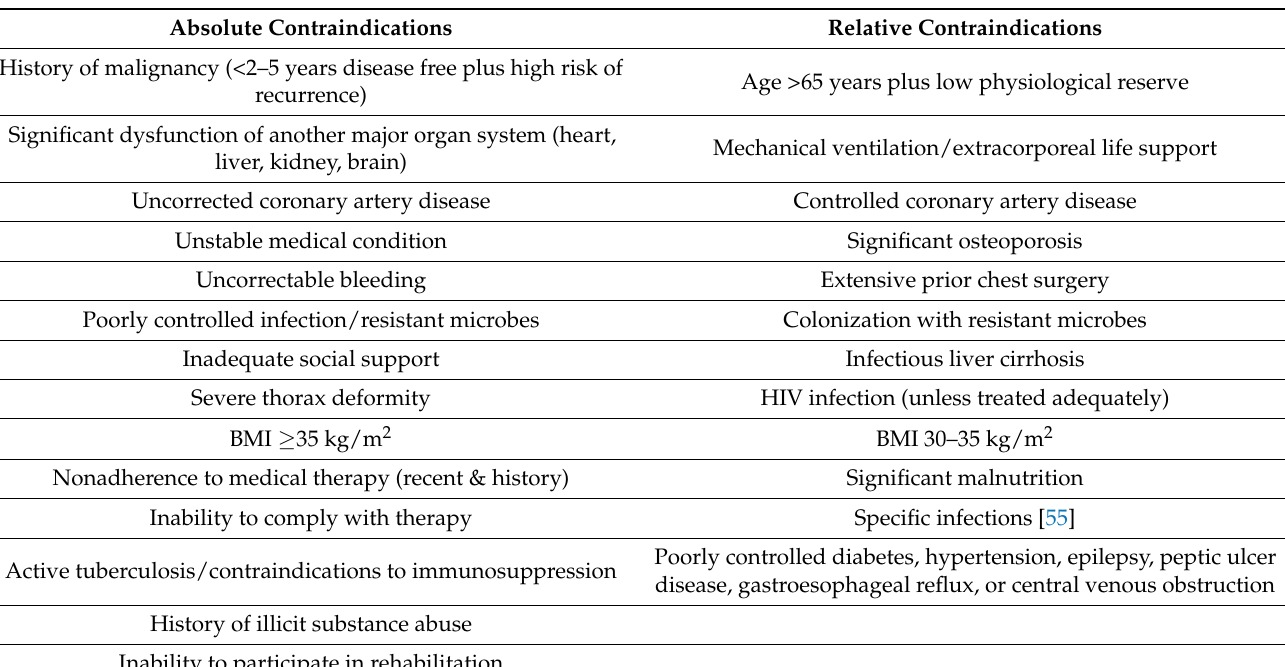
Table 2. Contraindications to lung transplantation (adapted from Weill 2018